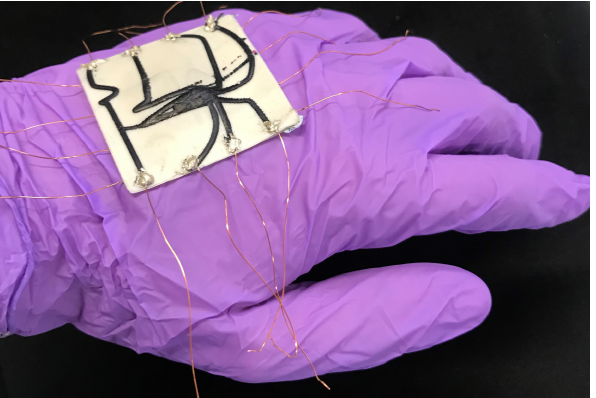
Figure 1. A 3D-printed soft sensory fiber network functioning as a flexible